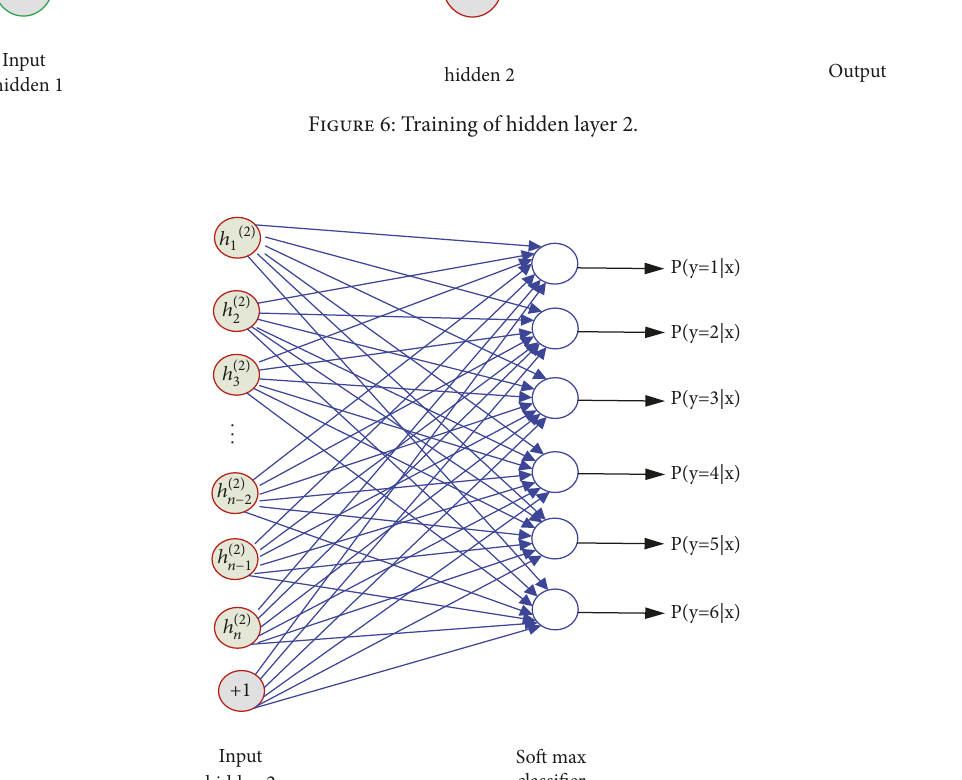
Figure 7: Training of the softmax